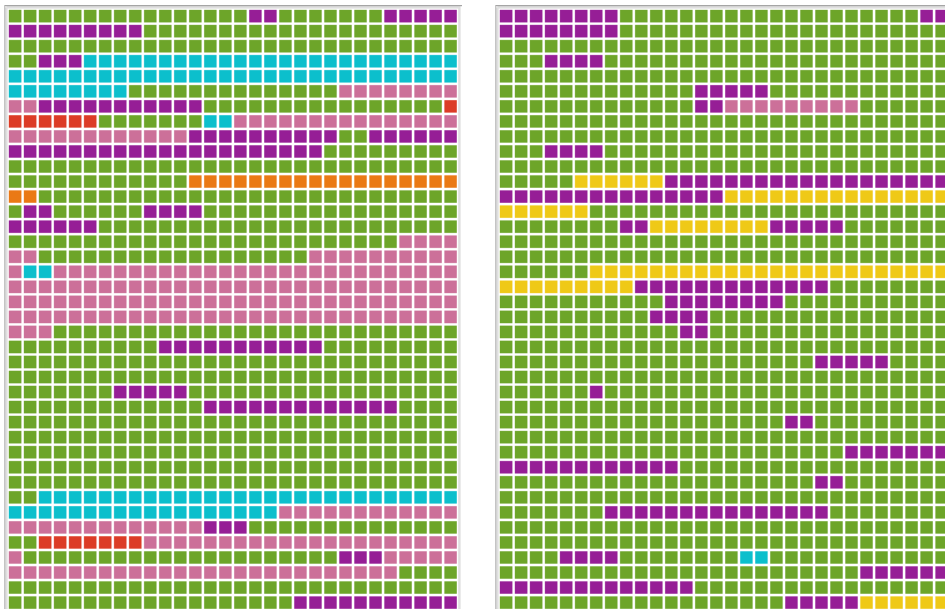
Figure 5. Document portraits of P3–F2F diagnostics ( left ) and telediagnostics ( right ) showing the sequence of codings for the selected document weighted by the length of the segments. Colours of the code system are purple (verbal), pink (expression of excessive demand), red (nonverbal), orange (perceptual), yellow (use of aids), green (executive functions), light blue (affective), and deep blue (aids of relatives).